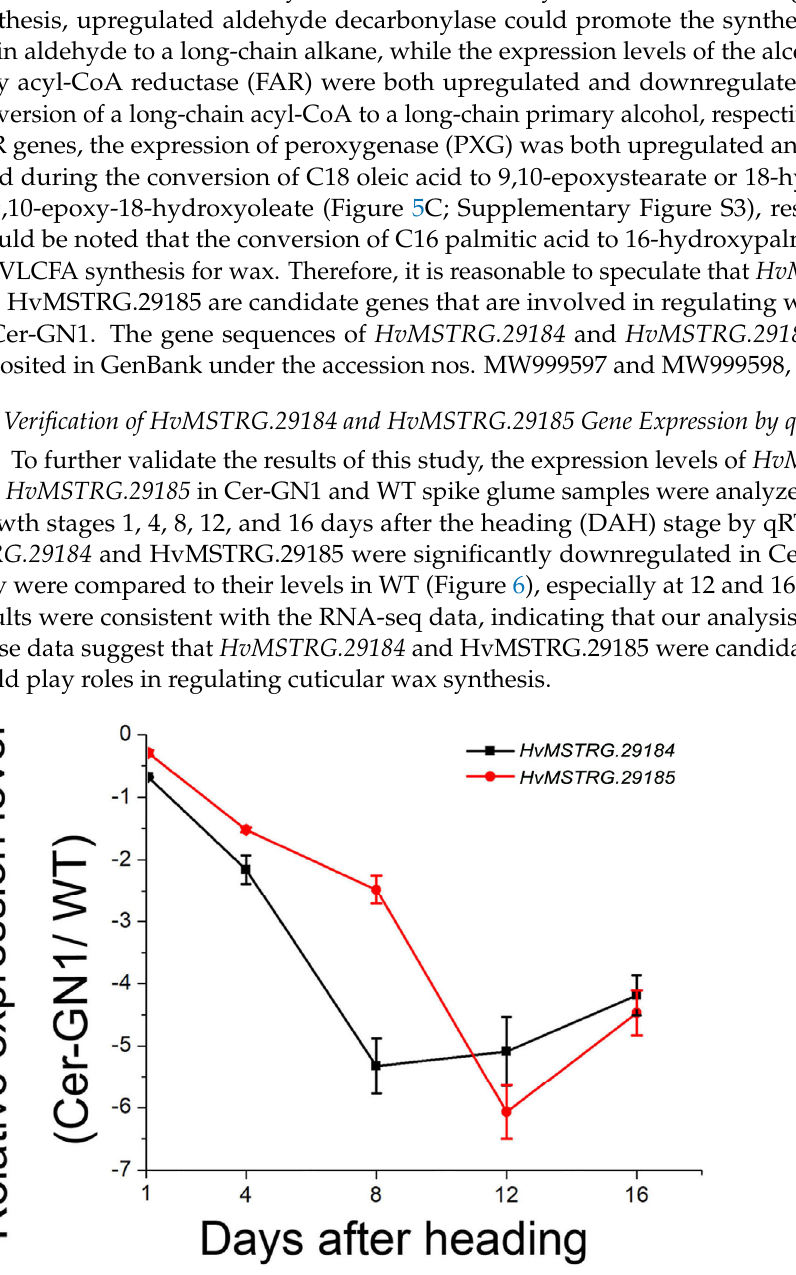
Figure 6. qRT-PCR validation of candidate genes HvMSTRG.29184 and HvMSTRG.29185 regulating wax synthesis in the Cer-GN1 mutant. The cuticular wax phenotype of the spikes of Cer-GN1 mutant and WT plants at 1, 4, 8, 12, and 16 days after heading (DAH). The scale bars represent the standard deviation of three biological replicates. Relative RNA expression levels for HvMSTRG.29184 and HvMSTRG.29185 were determined using mutant and WT gene-specific